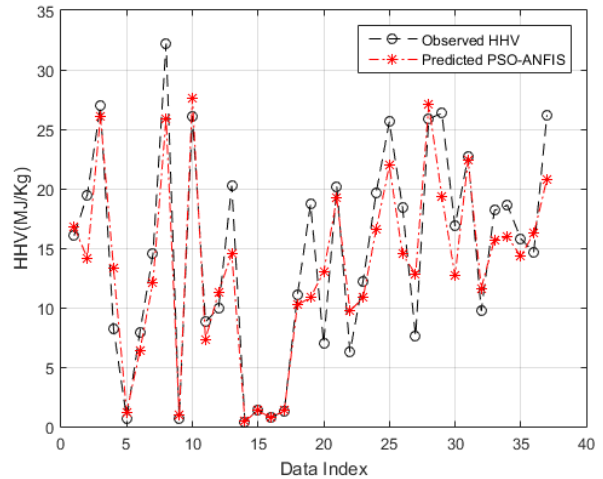
Figure 3. Comparison of experimental and predicted HHV for PSO-ANFIS at testing stage